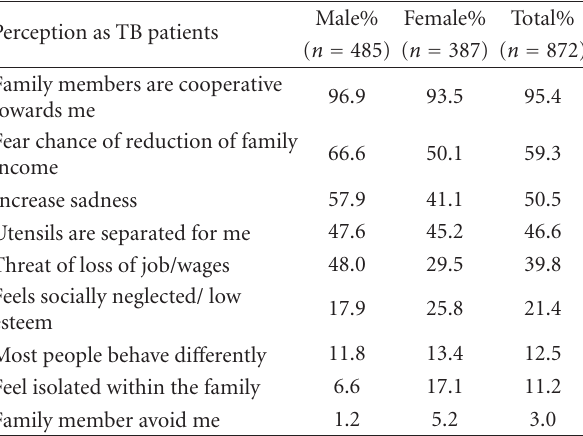
Table 5: Perception about how TB would be cured.